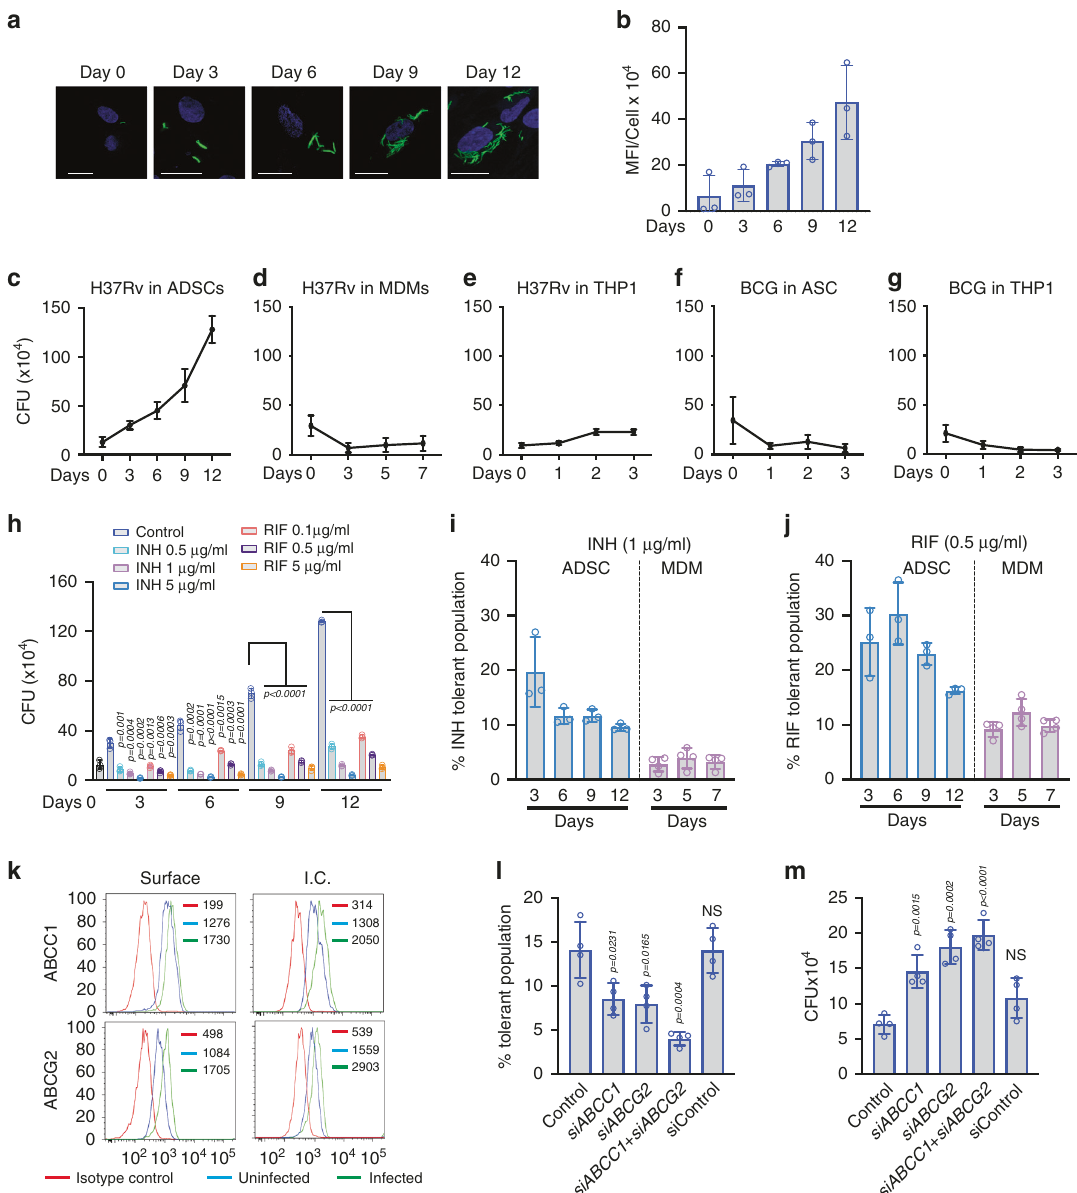
Fig. 1 ADSCs support better H37Rv survival and high drug tolerance. a Representative confocal images of GFP-H37Rv -infected ADSCs at 0 h, 3rd, 6th, 9th, and 12th days post infection (dpi), Scale bars, 20 µ m. b MFI of GFP-H37Rv /cell across above mentioned time points is represented in bar graph as mean ± SD, n = 3 independent experiments, each representing fi ve fi elds consisting of 25 – 100 cells. c Growth kinetics of H37Rv within ADSCs across 12 dpi. d Growth kinetics of H37Rv within human MDMs across 7 days post infection and ( e ) in THP-1 macrophages across 3 days. f Growth kinetics of BCG within ADSCs and THP-1 macrophages ( g ) across 0, 1, 2, and 3 dpi. h H37Rv -infected ADSCs were treated with doses of isoniazid (INH), and rifampicin (RIF) for 24 h prior to 3rd, 6th, 9th, and 12th dpi, and were plated for CFU enumeration. n = 3 donors, **** p < 0.0001. i Percent drug-tolerant bacterial population to INH (1 µ g/ml) within ADSCs (blue) on 3rd, 6th, 9th, 12th days and within MDMs (purple) on 3rd, 5th, and 7th dpi, respectively (see Methods). n = 3 donors (ADSC), 4 donors (MDM). j Percent drug-tolerant bacterial population to RIF (0.5 µ g/ml) within ADSCs (blue) on 3rd, 6th, 9th, and 12th days and within MDMs (purple) on 3rd, 5th, and 7th dpi, respectively. n = 3 donors (ADSC), 4 donors (MDM). k Line histogram of surface and intracellular (I.C.) staining of ABCC1/MRP-1 and ABCG2/BCRP in uninfected and in H37Rv -infected ADSCs, 6 dpi. Numbers represent MFI of individual colored histogram. l Percent INH (1 µ g/ml) tolerant bacterial population in ADSCs after knocking down ABCC1 (200 nM siRNA) or ABCG2 (200 nM siRNA) alone or in combination, in H37Rv -infected ADSCs, n = 4 independent experiments. m H37Rv CFU from 6th day infected ADSCs after siRNA mediated knockdown of ABCC1 and ABCG2 for 48 h prior to the time point. n = 4 independent experiments. All data were analyzed by two-tailed unpaired Student ’ s t test and represented as mean ± SD. Source data are included in the source data fi le. population within ADSCs (Fig. 1l and Supplementary Fig. 3f). (Supplementary Fig. 3e). Since pharmacological inhibitors may When ABCC1 and ABCG2 both were knocked down simulta- still have off-target effects, we knocked down these transporters neously, the tolerant bacterial population declined further, using speci fi c siRNAs. Knocking down either ABCC1 or ABCG2 reaching nearly 2 – 4 % (Fig. 1l). There was no such effect on drug- led to a substantial decline in the drug-tolerant bacterial NATURE COMMUNICATIONS| (2020) 11:3062